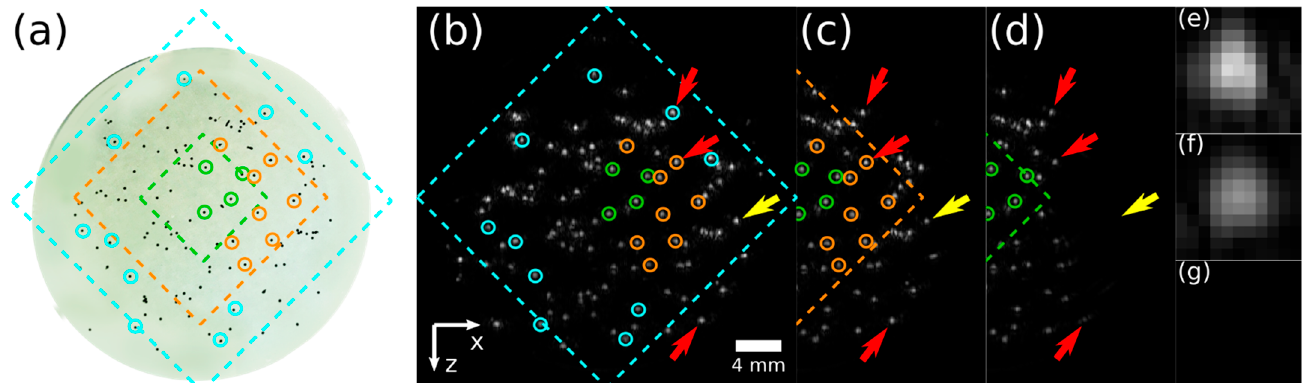
Figure 4. US images of phantom Ph1 performed with different translation ranges L . ( a ) Optical picture showing the spatial distribution of microspheres. ( b – d ) Maximum amplitude projection (MAP) images along the y-axis for L = 30, 20, and 10 mm, respectively. The dotted diamond indicates the area probed with all the different orientations of the array, named diamond-shaped, cross-sectional area (DSCA) (Figure 1c). The MAP images are in linear gray scale. The same gray scale was used for ( b – d ). For a better readability, the gray scale was fixed. White pixels correspond to the maxima of the MAP image for L = 30 mm. Black pixels correspond to an amplitude equal to zero. The islets ( e – g ) show a zoom of the microsphere, indicated with the yellow arrow for L = 30, 20, and 10 mm, respectively. The pixels displayed in white correspond to the maximum for L = 30 mm. The red arrows show microspheres located outside of the DSCA in ( d ). The yellow arrow points to a microsphere inside the blind area in ( d ). Full-size images corresponding to ( c , d ) are displayed in Figure S1.